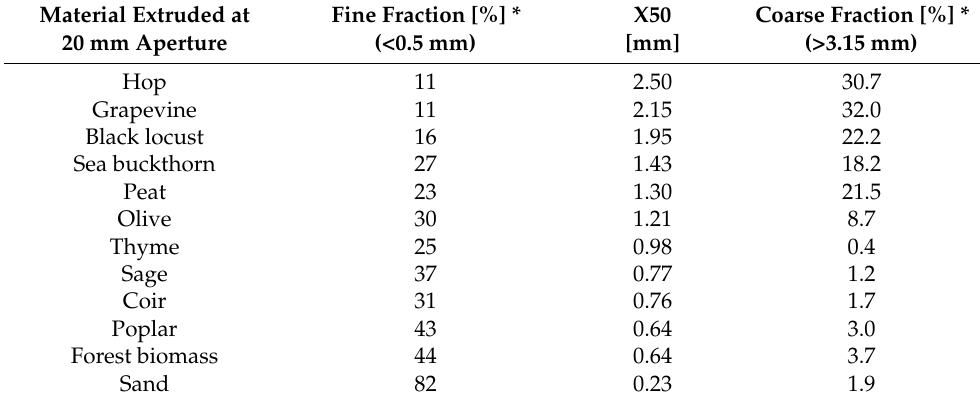
Table 3. Comparison of different extruded materials for fine fraction, coarse fraction and X50-value at 20 mm aperture and peat, coir and sand (not